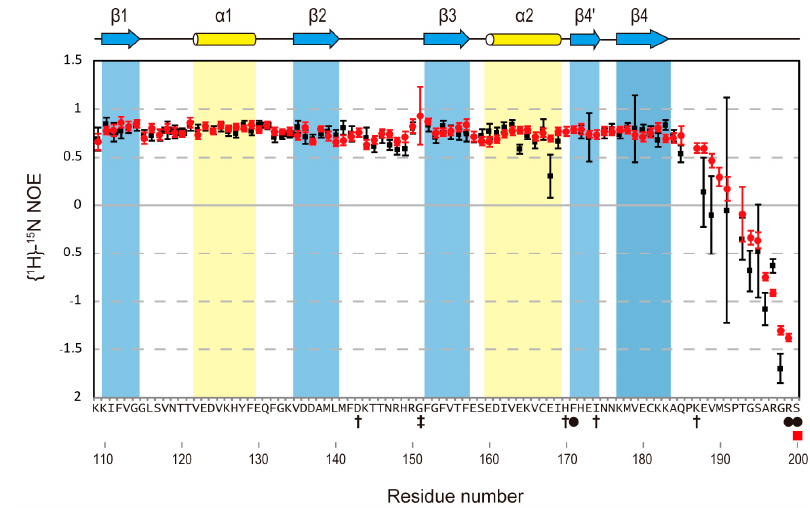
Figure 4. Comparison of the heteronuclear steady-state { 1 H}- 15 N nuclear Overhauser effect (NOE) values for Msi1(109–200) in its free and bound forms. The heteronuclear steady-state { 1 H}- 15 N NOE values are shown for Msi1(109–200) in the free form (black squares) and in the complex form with r(GUAGU) (red circles). The secondary structure elements (helices: yellow cylinders; β -strands: blue arrows) of Msi1(109–200) are shown at the top. The amino acid residues whose 1 H- 15 N resonances were not assigned are indicated by black circles (free form) and a red square (complex form) beneath the amino acid sequence at the bottom. Daggers indicate the residues with overlapped 1 H- 15 N resonances, while double-daggers indicate the residues whose 1 H- 15 N resonance was missing in the free form.